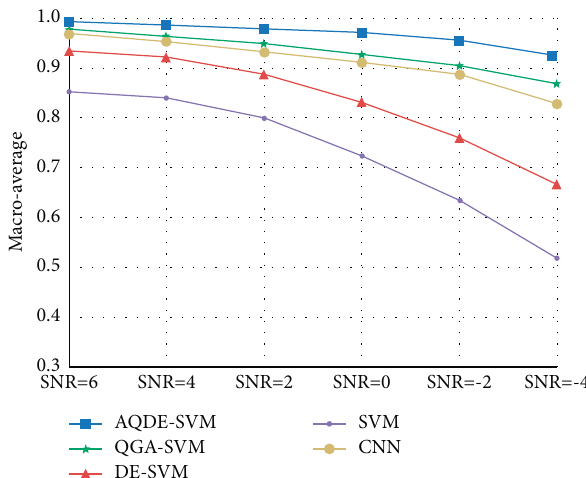
Figure 8: Bearing2_1 dataset fault threshold.